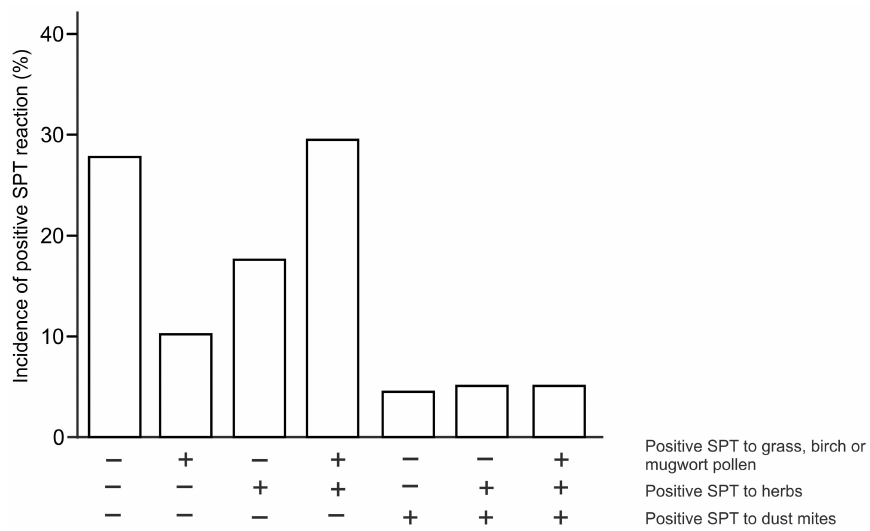
Figure 1. Incidence of single or concomitant positive SPT reactions to standardized birch, mugwort and grass pollen extracts, standardized dust mite extracts and fresh herbs extracts in the studied group of patients ( n = 180), adults and children.